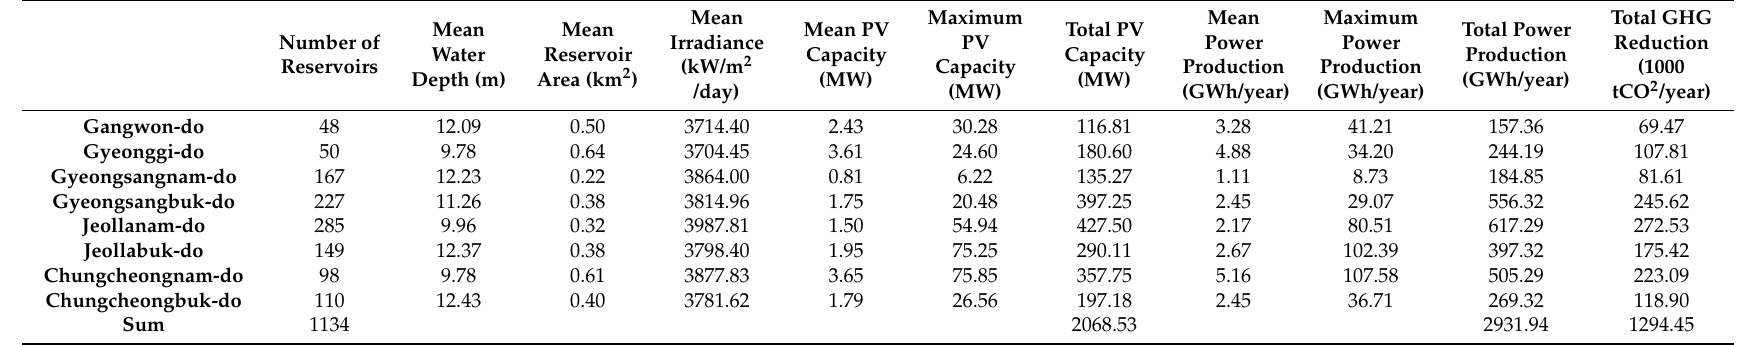
Table 3. The results of reservoir condition, installed floating photovoltaic (PV) capacity, annual power production, and greenhouse gas (GHG) reduction of each